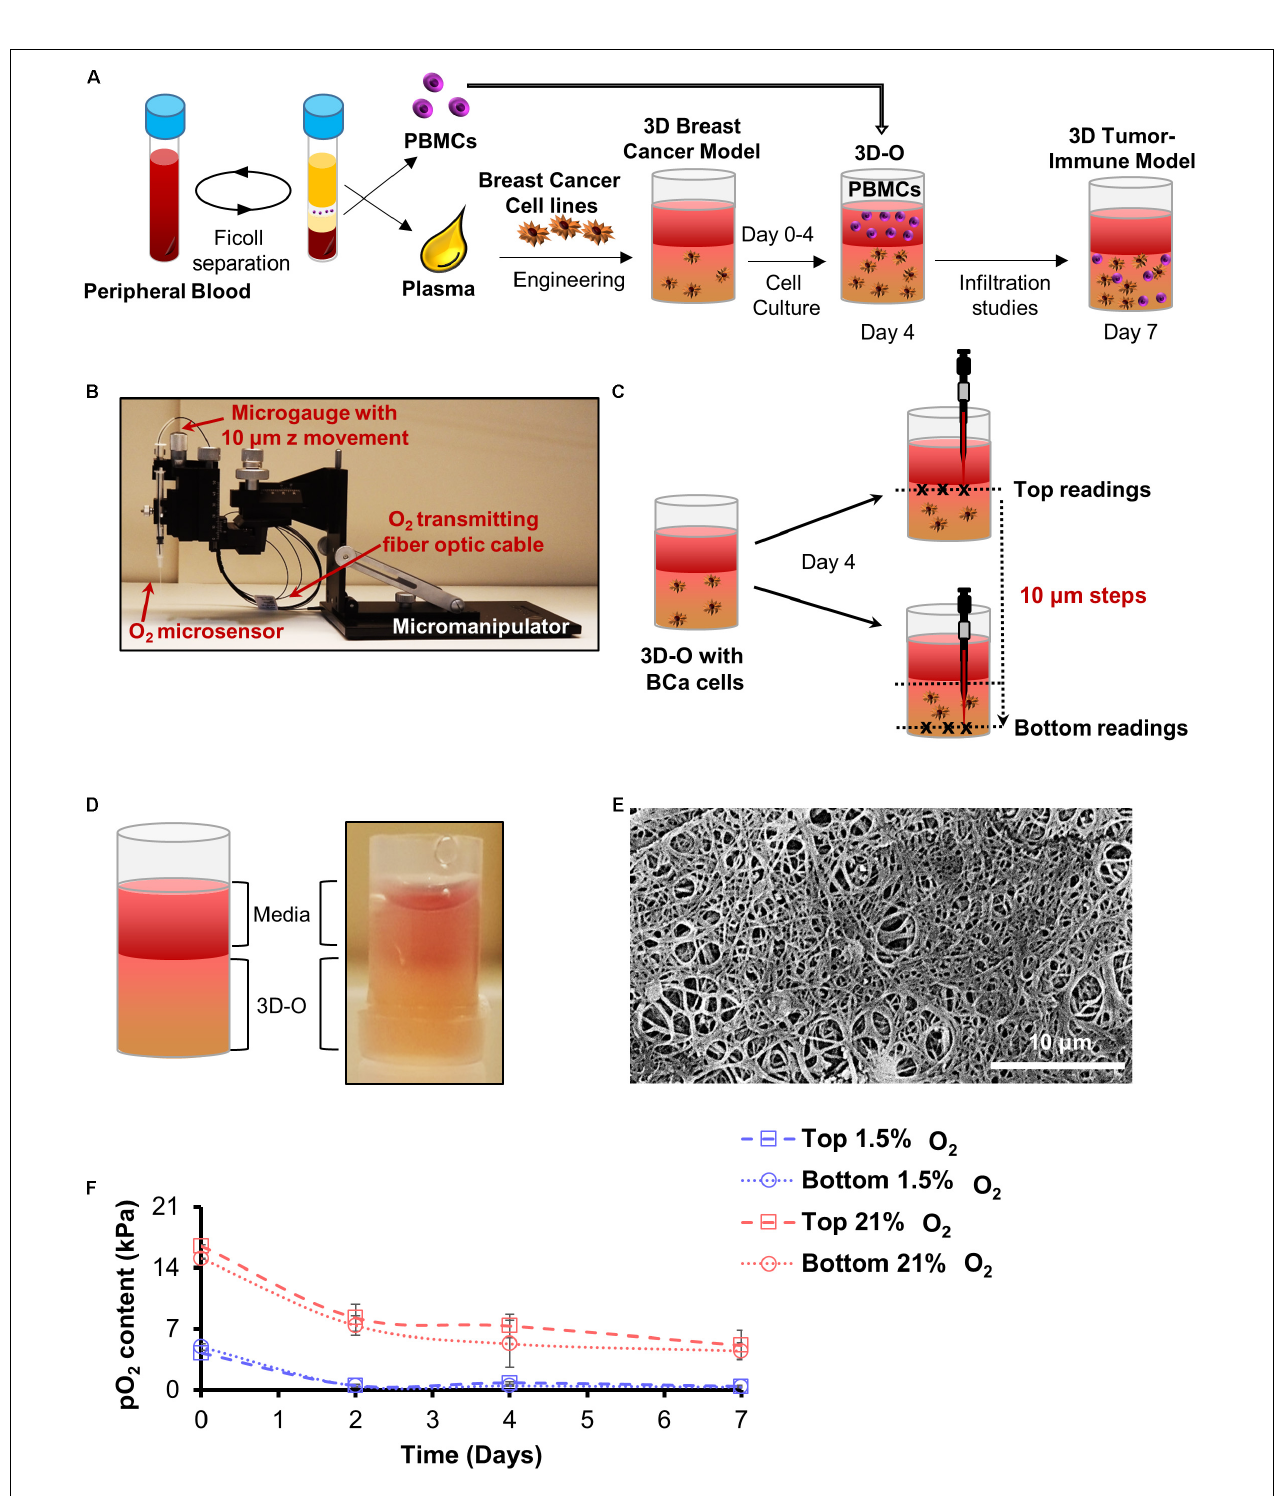
FIGURE 1 | Development of 3D-O matrices. (A) 3D-O matrices were developed through cross-linking of fibrinogen (naturally found in the plasma of blood supernatant) including BCa cells. PBMCs were added on top of the 3D-O scaffolds on day 4 of culture and allowed to infiltrate into the scaffold until day 7. (B) Oxygen microsensor and Manual Micromanipulator configuration for O 2 profiling in the Z-direction every 10 mm. (C) Oxygen microsensor was extended delicately and safely with 10 mm profiling accuracy to determine surface (border between media and 3D-O matrix) and bottom (bottom of the well) readings. (D) Visual and schematic representation of a 3D-O matrix with the medium on top. (E) SEM micrograph of acellular 3D-O scaffold cultured on day 4. Scale bar: 10 µ m. (F) Average top to bottom pO 2 levels (kPa) obtained from 3D-O matrices embedded with MDA-MB-231 and MCF-7 BCa cells, incubated up to 7 days under 21% and 1.5% O 2 .